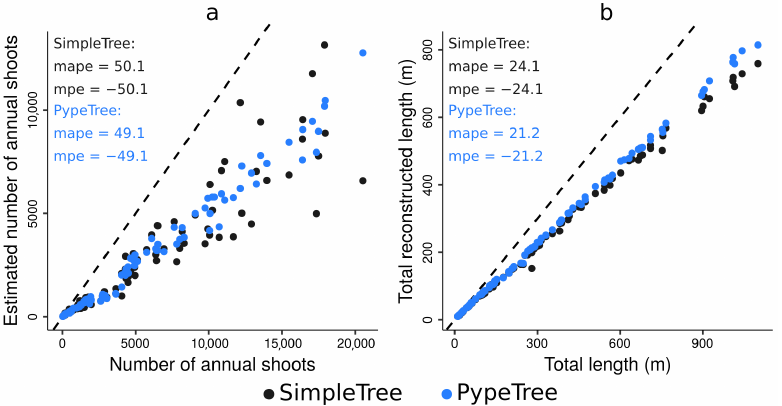
Figure 12. Evaluation of skeletonization and annual shoot segmentation in 110 simulated terrestrial laser scanning (TLS) scans of 110 simulated trees (5 to 15 years with 10 trees per age) reconstructed with two quantitative structural model (QSM) methods. Number of segmented annual shoot ( a ) and total reconstructed length ( b ) cumulated at the tree level. Evaluations were done against the real AS number and length observed in the output of the AMAPsim model. The dotted line represents the 1:1 relation. The Mean Absolute Percentage Error (mape, %) and Mean Percentage Error (mpe, %) are indicated on the